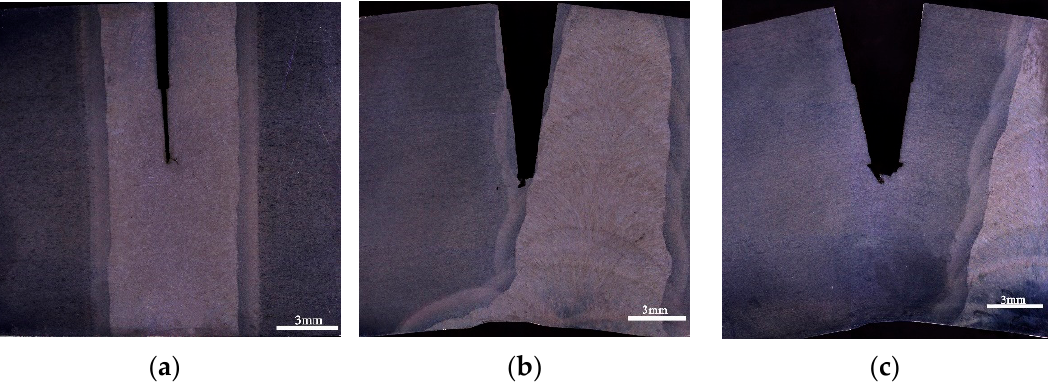
Figure 8. Typical CTOD profiles in the H 2 S ‐ containing environment: ( a ) WM, ( b ) CGHAZ, ( c ) SCHAZ.